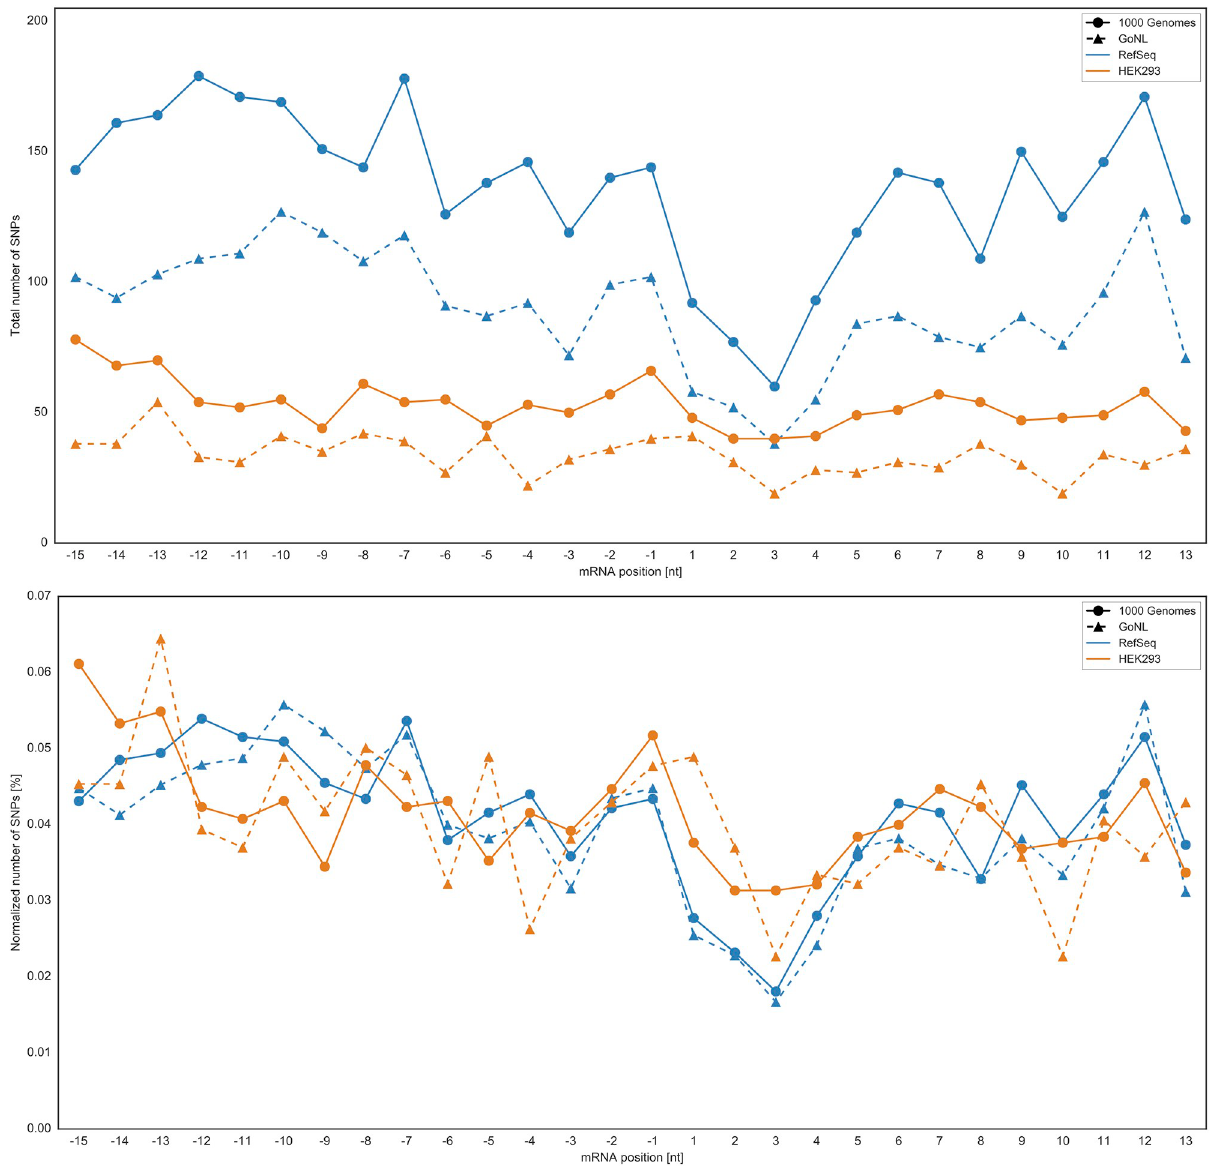
Fig 6. SNP distribution in the flanking region of the coding start site (CSS). SNP pattern in the flanking region (–15 to +13) of canonical and alternative starts. The applied permutation test provided the following p-values (curves from top to bottom): RefSeq+1000G: 0.0, RefSeq+GoNL: 0.0002, HEK293+1000G: 0.027, HEK293+GoNL: 0.244. With a significance threshold of p < 0 : 05 ¼ 0 : 0125 , the drop in the total number of SNPs at the CSS is 4 significant only for canonical start sites. Upper panel: total number of SNPs; Lower panel: the number of SNPs normalized by the number of sequence contexts with at least one SNP, compare with Table 1.